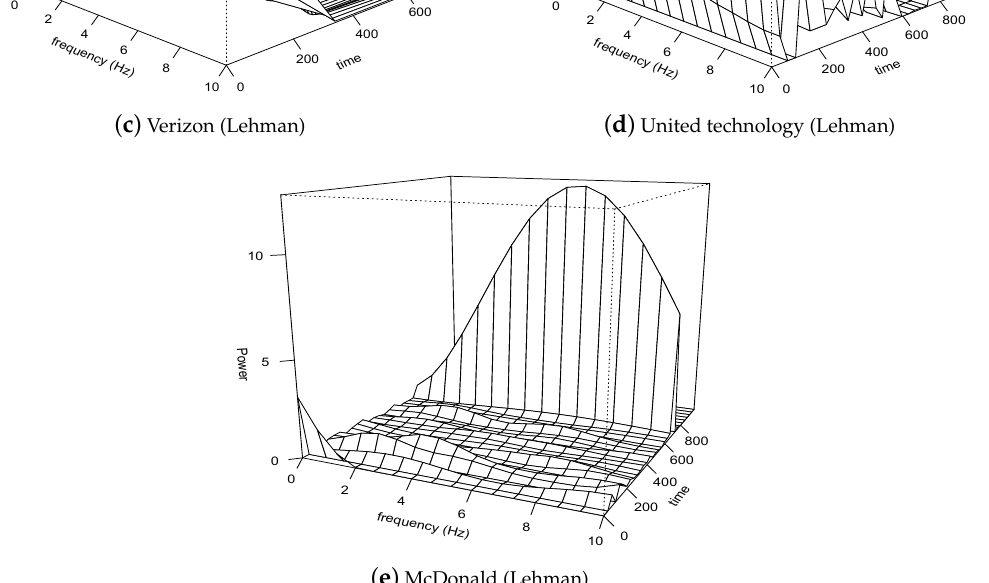
Figure 4. The energy levels of the financial data corresponding to the Lehman Brothers